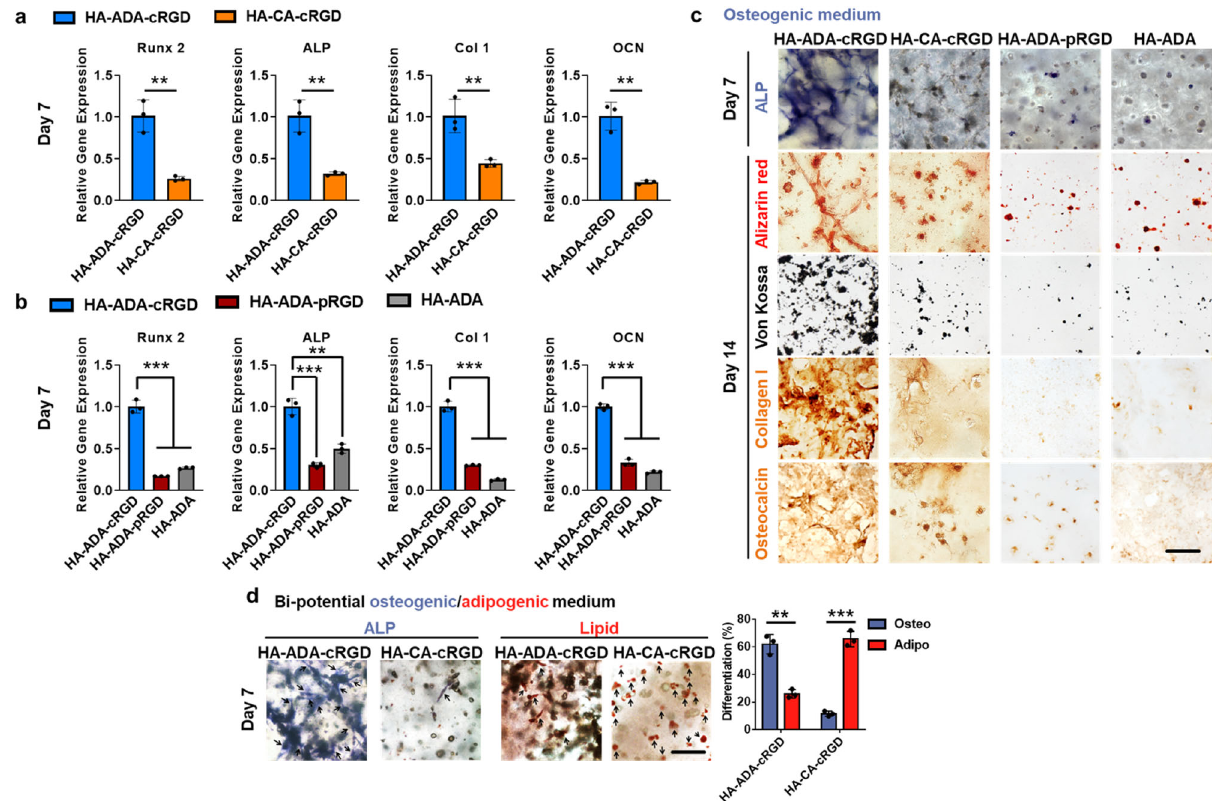
Fig. 5 Supramolecular hydrogels with short crosslink lifetime promote osteogenic differentiation of encapsulated hMSCs. a Quanti fi cation of Runx 2, ALP, type I collagen, and OCN gene expression of hMSCs encapsulated in the hydrogels (HA – ADA – cRGD and HA – CA – cRGD) by RT-PCR after 7 days of osteogenic culture. Values are normalized to expression levels within HA – ADA – cRGD. Data are presented as mean values± SD, n = 3 independent hydrogels; ** p < 0.01 (two-tailed Student ’ s t -test). b Quanti fi cation of Runx 2, ALP, type I collagen, and OCN gene expression of hMSCs encapsulated in